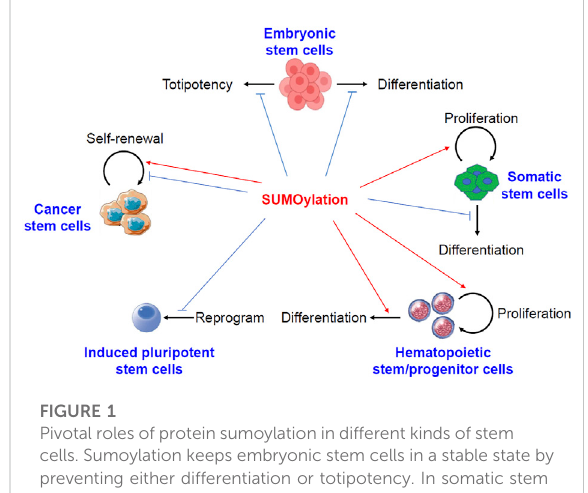
FIGURE 1 Pivotal roles of protein sumoylation in different kinds of stem cells. Sumoylation keeps embryonic stem cells in a stable state by preventing either differentiation or totipotency. In somatic stem cells, sumoylation promotes cell proliferation but